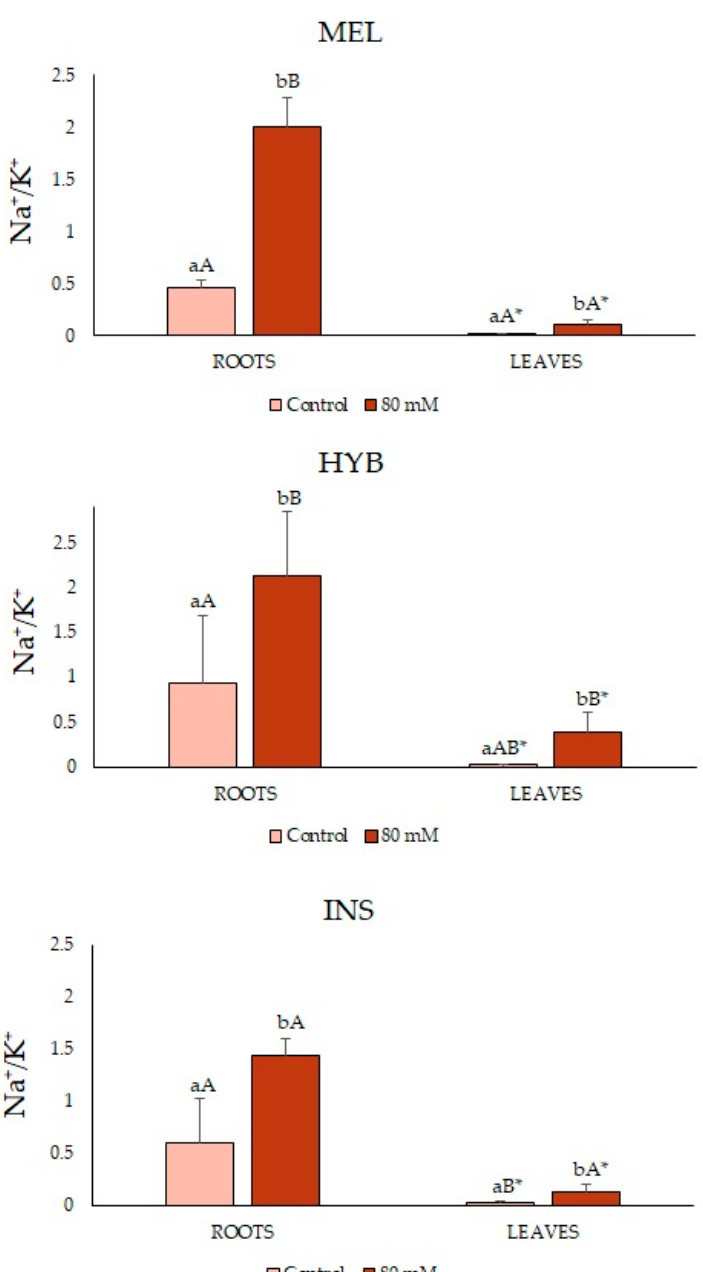
Figure 10. Na + /K + ratio in roots (left) and leaves (right) (mean ± SD; n = 5) in Solanum melongena (MEL), Solanum insanum (INS) and their hybrid (HYB) in the conditions tested (control, 80 mM of NaCl). Different lowercase letters within the same genotype indicate statistically significant differ- ences between treatments, different uppercase letters within the same treatment indicate statistically significant differences between genotypes, and an asterisk indicates statistically significant differ- ences between roots and leaves for the same treatment and genotype ( p < 0.05), according to the Student–Newman–Keuls multiple range test.